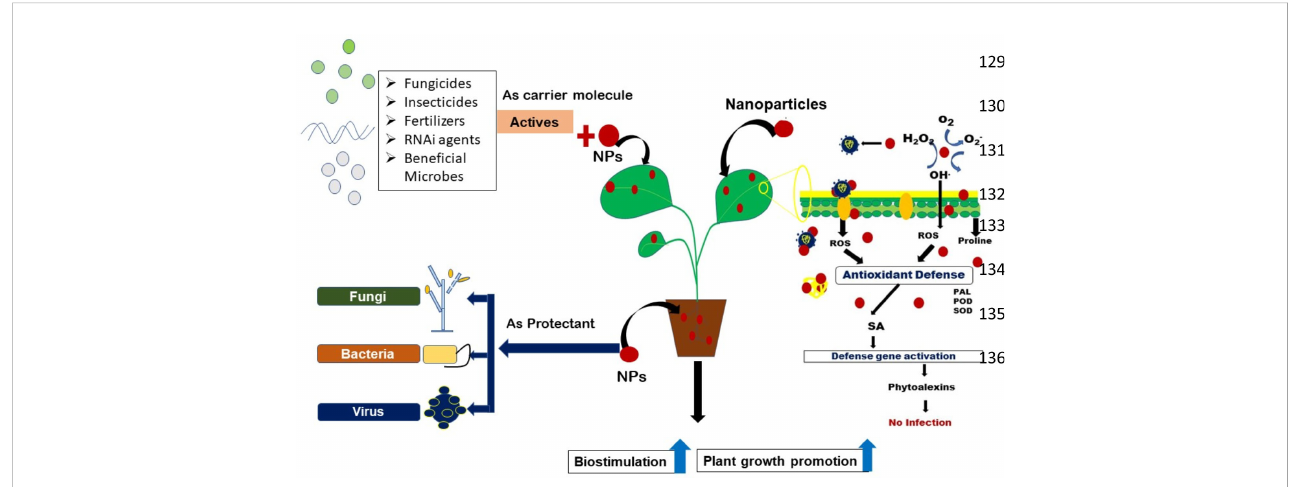
FIGURE 1 Schematic representation of different approaches of nanoparticles for management of soil borne plant